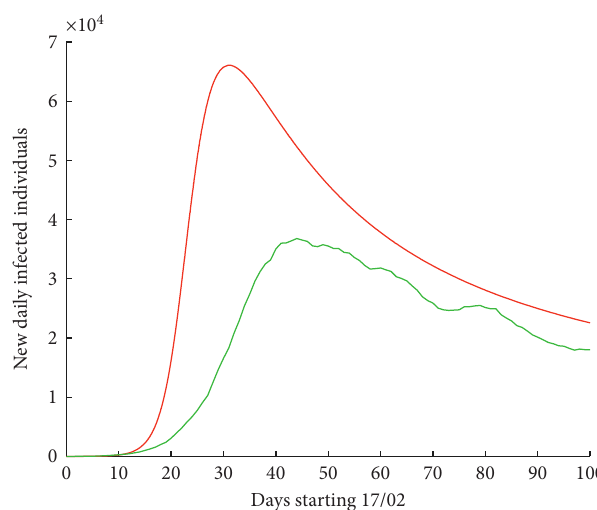
Figure 8: Number of new daily infected individuals in Europe, starting 17 February 2020 for 100 days. Real data are shown in green colour, while the result of the numerical simulations of the hypothetic curve with 35% more of infectivity is shown in red